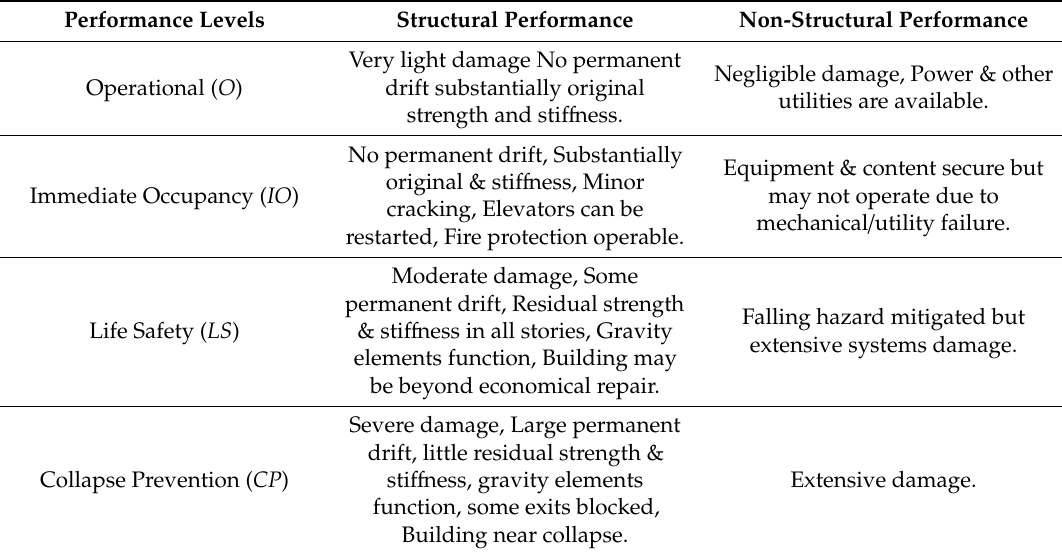
Table 6. Performance levels (adapted from [53]).